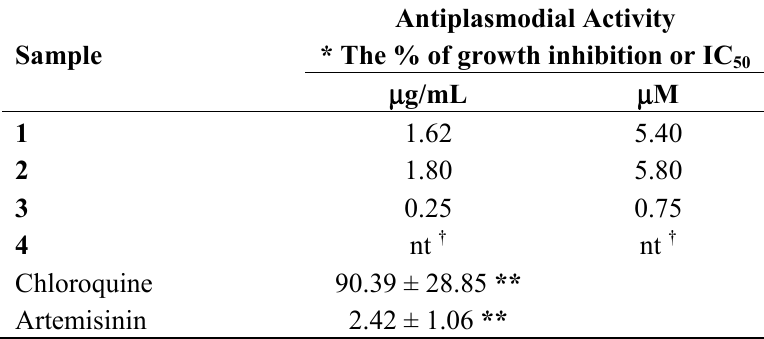
Table 1. In vitro Antiplasmodial Activities of Alkaloids from Cryptocarya nigra